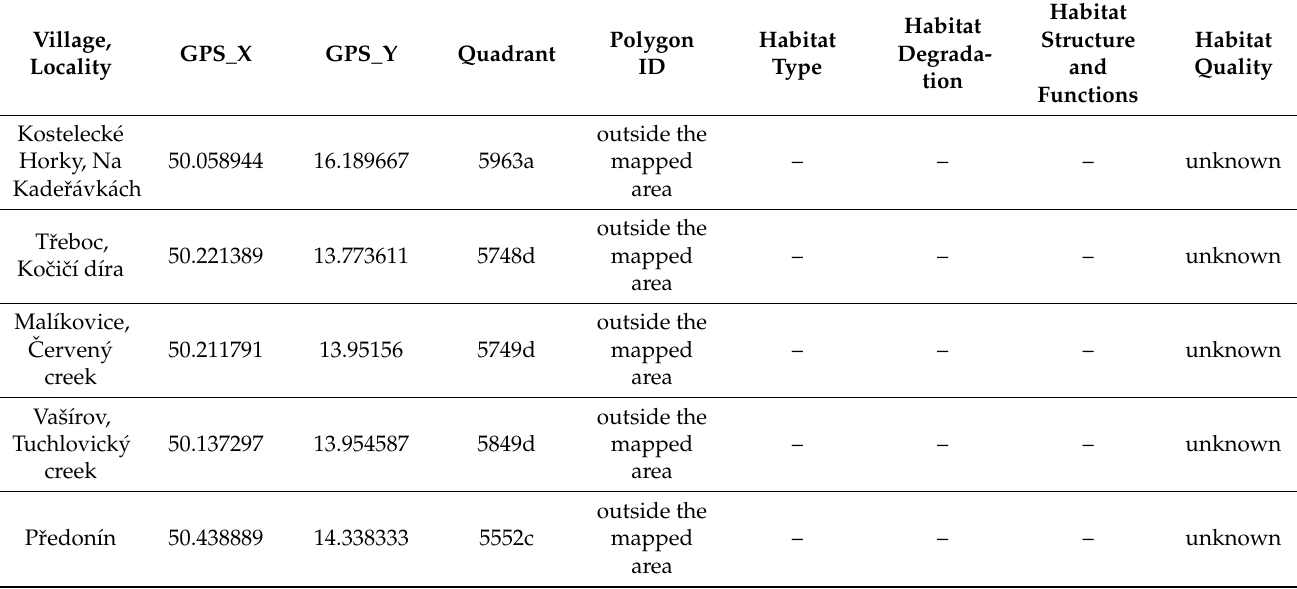
Table 1. Example of source data (sample) of Carex lepidocarpa for assessment of habitat quality. Darker colours indicate lower values of quality. FV = favourable, U1 = unfavourable—inadequate, U2 = unfavourable—bad but stable.